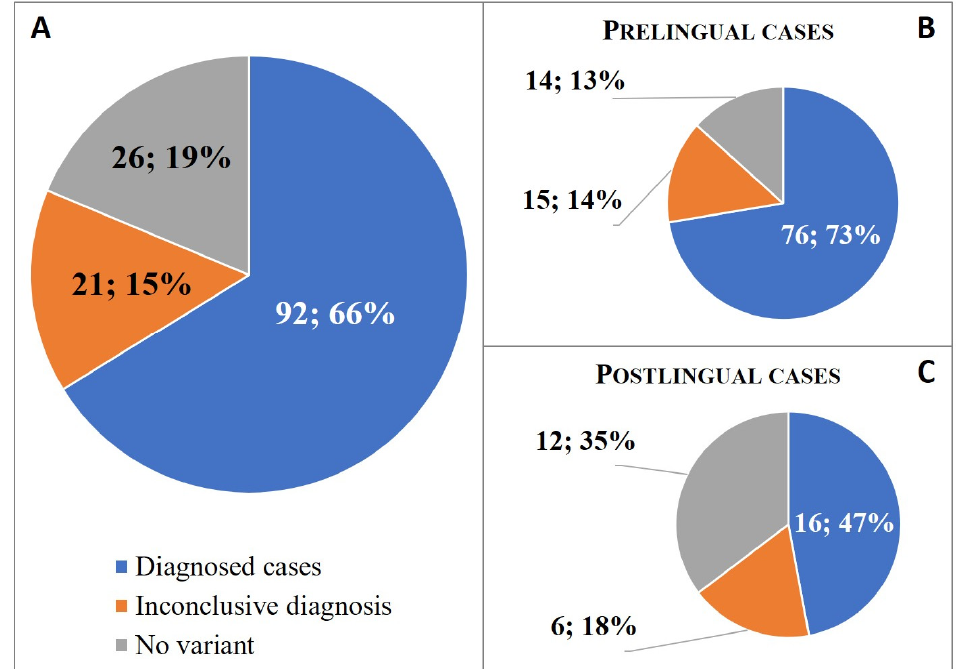
Figure 2. Distribution of diagnosis for patients in the Hungarian NSHL patient cohort. Numbers within the sections of the circular chart: number of patients; percentage of patients. ( A ) Complete (N = 139); ( B ) prelingual NSHL (N = 105); and ( C ) postlingual NSHL (N = 34) cohorts.